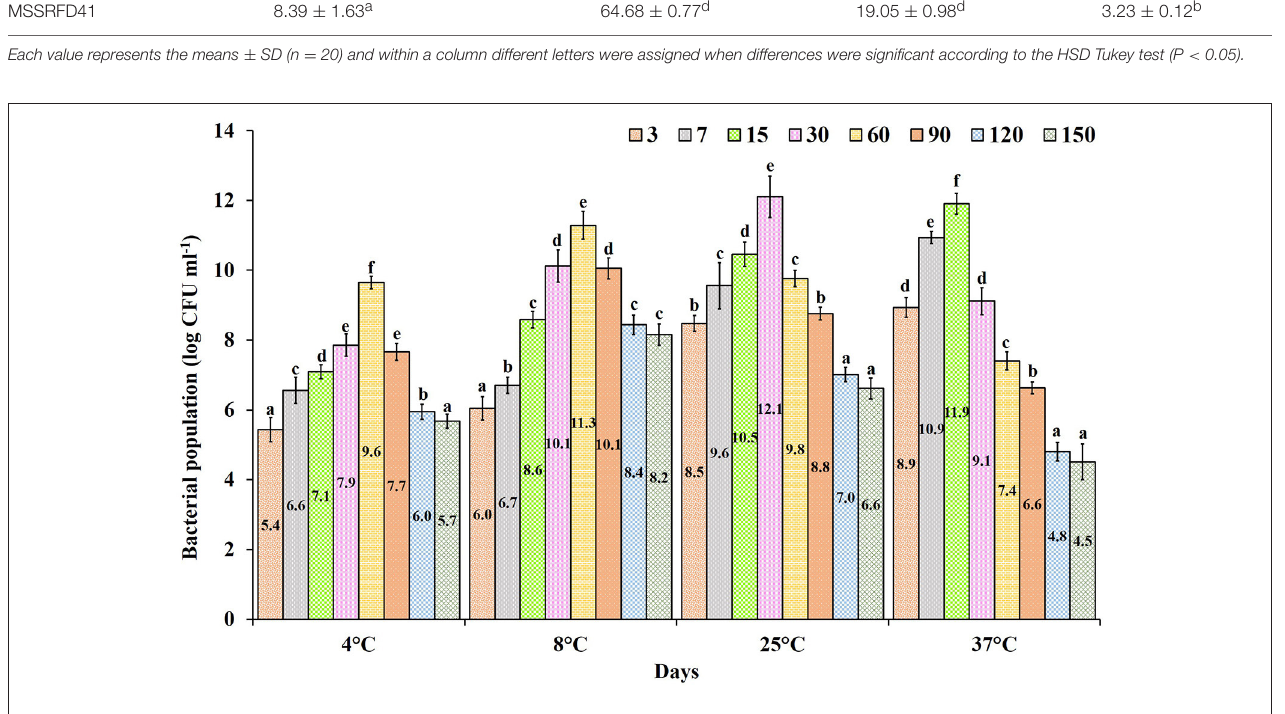
FIGURE 4 | Shelf life of Pseudomonas sp. MSSRFD41 in liquid formulated product of different ages incubated at various temperatures. Each value is the mean ± SD of 3 replicates. Within a column, different letters were assigned when significant according to the HSD Tukey test ( P <